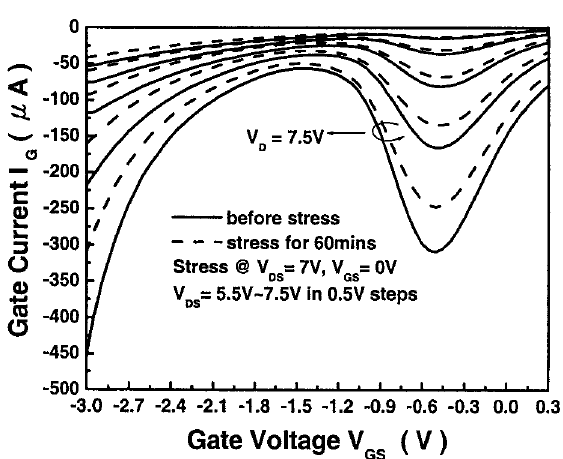
FIGURE 5 Gate current versus gate bias measured at different V DS values of AlGaAs = InGaAs = GaAs PHEMTs, before (solid line) and after (dashed line) stressing at V DS ¼ 7V ; V GS ¼ 0V